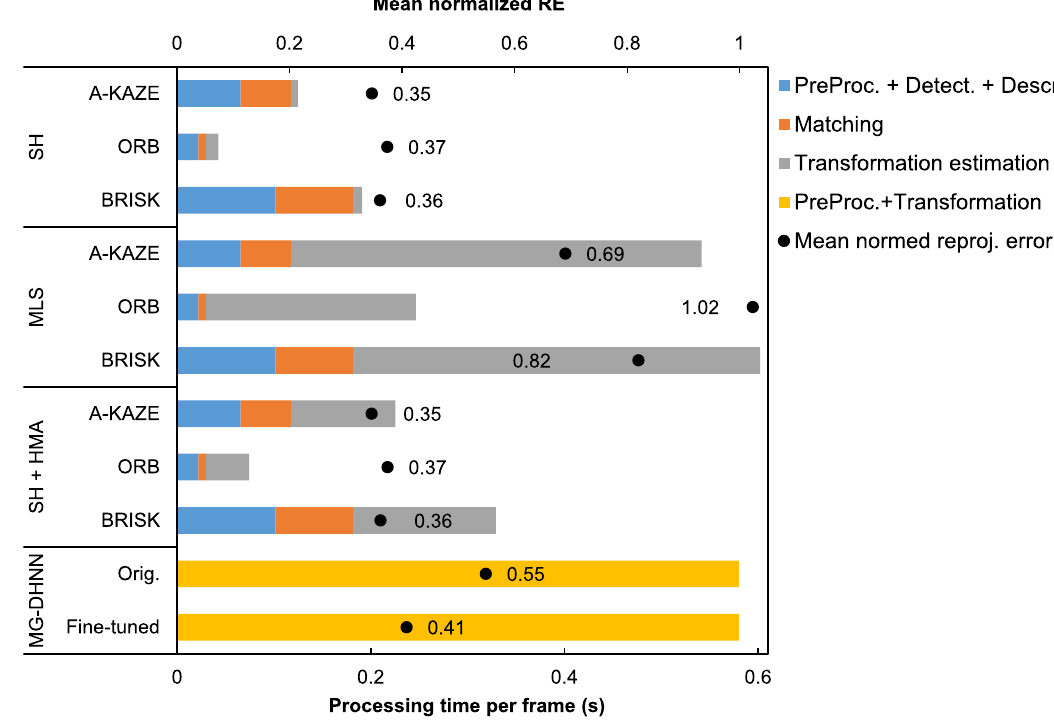
Figure 6. Mean processing time per frame and mean normalized reprojection error (RE) for each transformation and feature-detector-descriptor method. ORB is the short form of ORB1000.